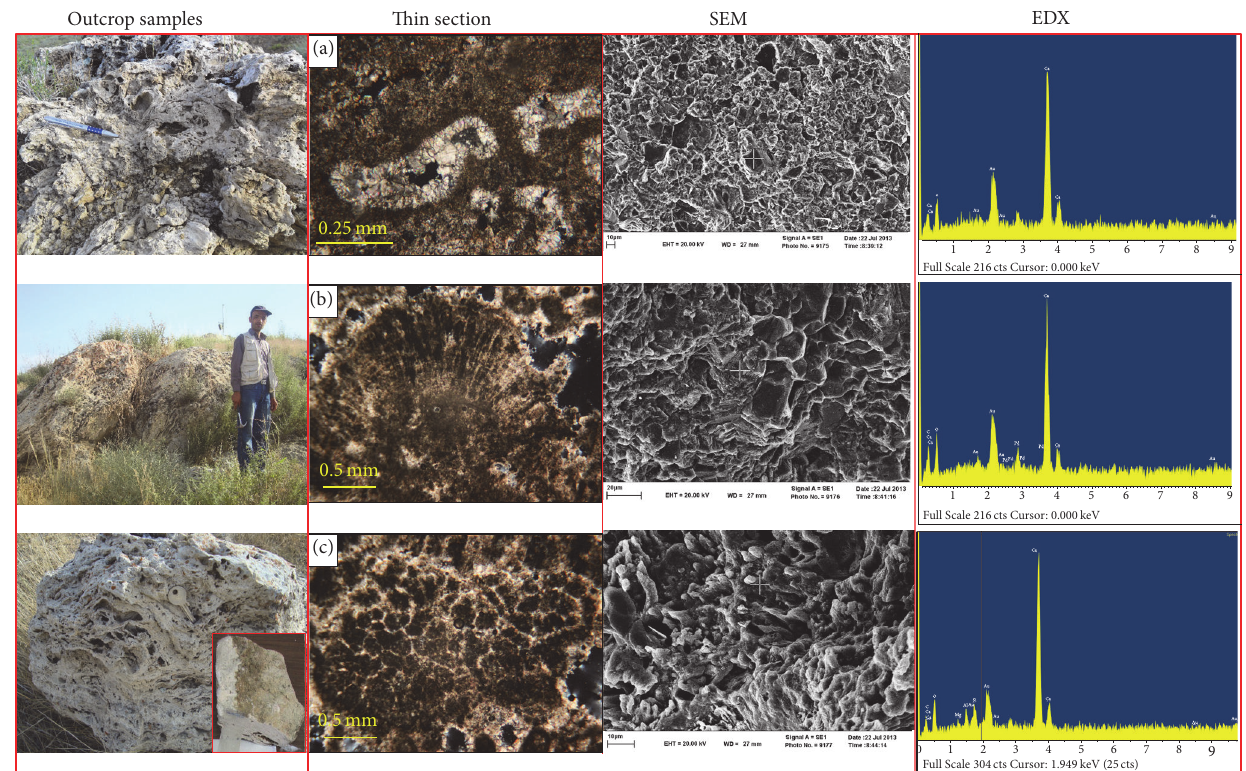
Figure 3: Travertines hand samples, thin sections, SEM images, and EDX